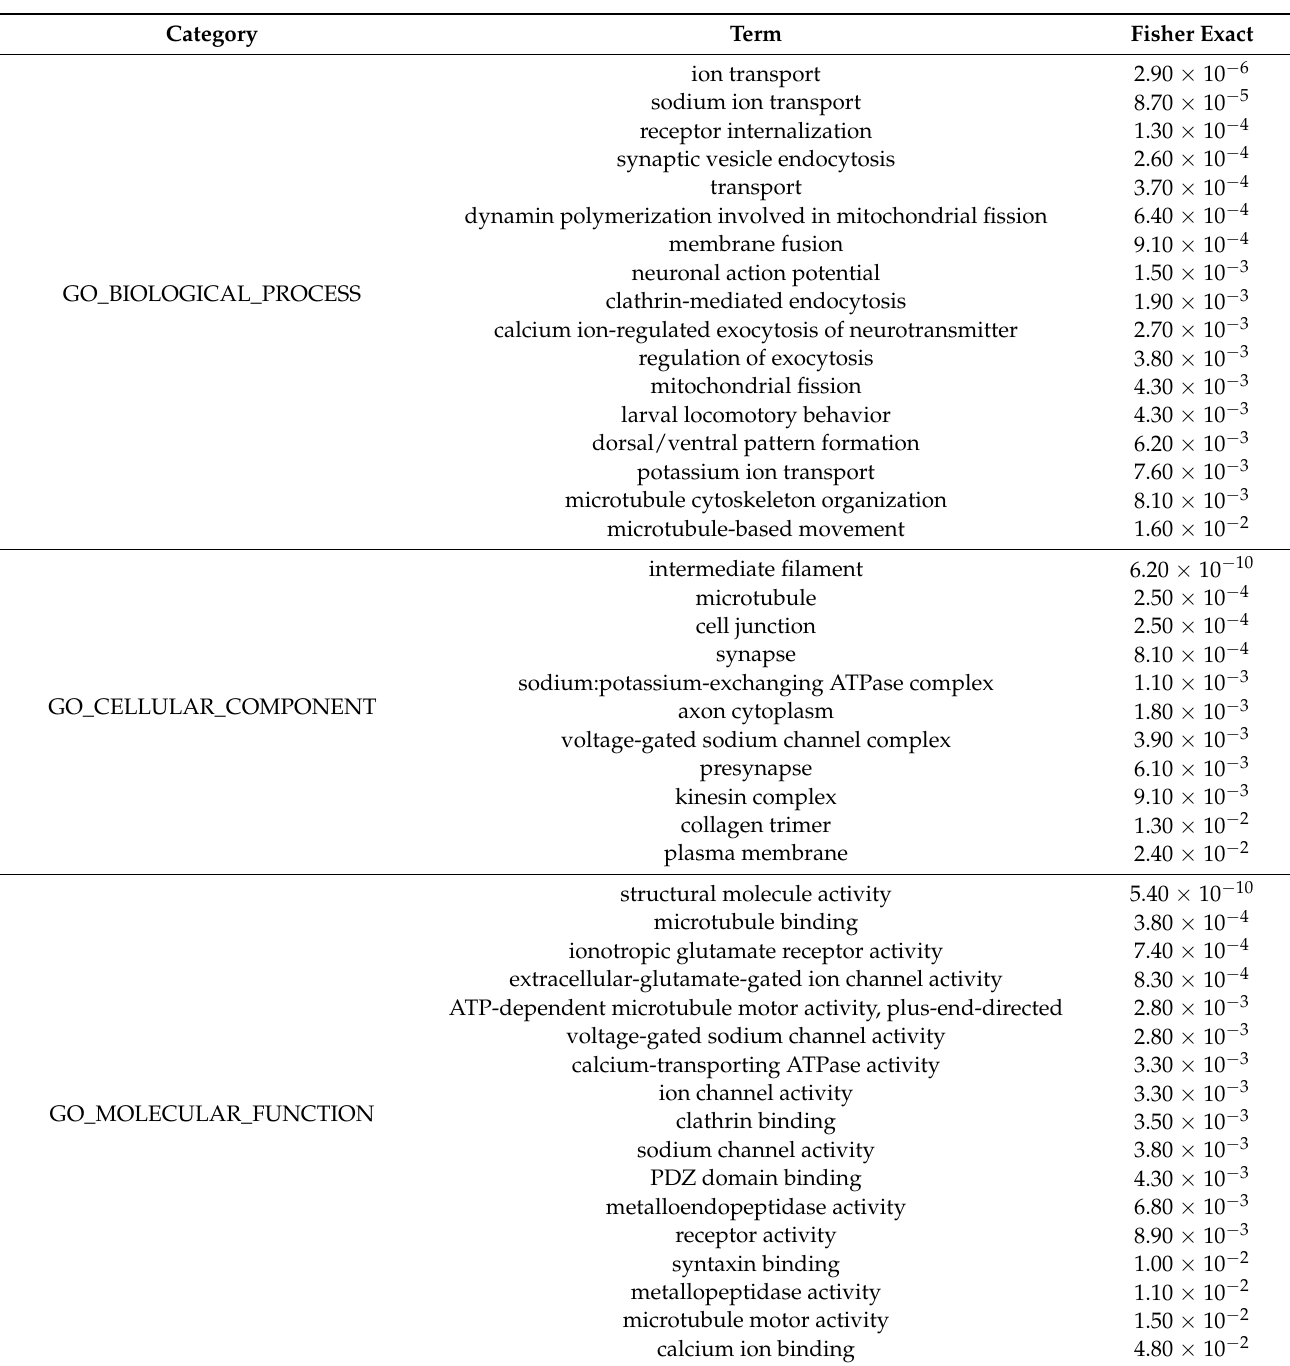
Table 2. The most significant categories of Gene ontology enrichment analysis based on the 157 d.e. transcripts.